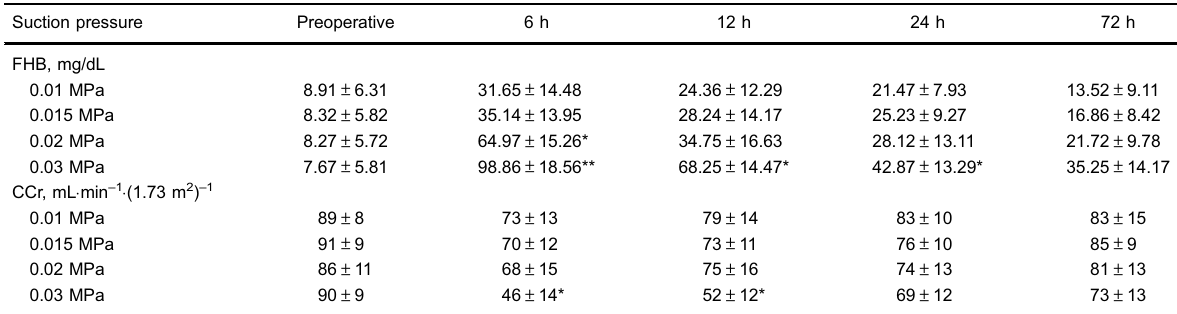
Table 6. Plasma free hemoglobin (FHB) and creatinine clearance (CCr) in pre-operative and 6, 12, 24, and 72 h post-operative patients under 3 transfusion units.